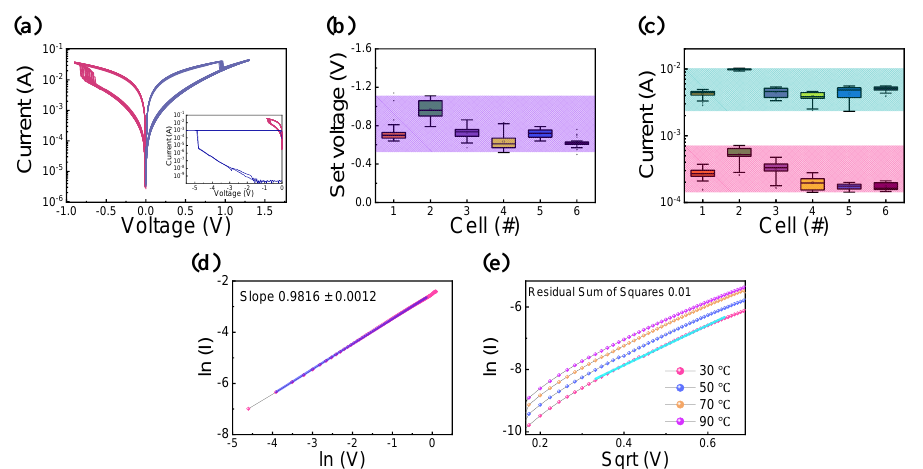
Figure 2. ( a ) Bipolar resistive switching of Pt/Ti/AlSiO x /W device. Box charts for cell-to-cell variation: ( b ) set voltage, ( c ) HRS and LRS at reading voltage of 0.1 V. Conduction mechanism I – V fitting: ( d ) in LRS, ( e ) in HRS.